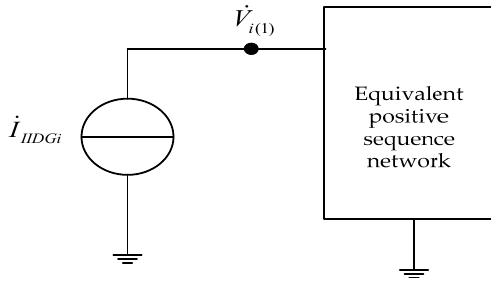
Figure 3. The equivalent positive-sequence current source model of IIDG.